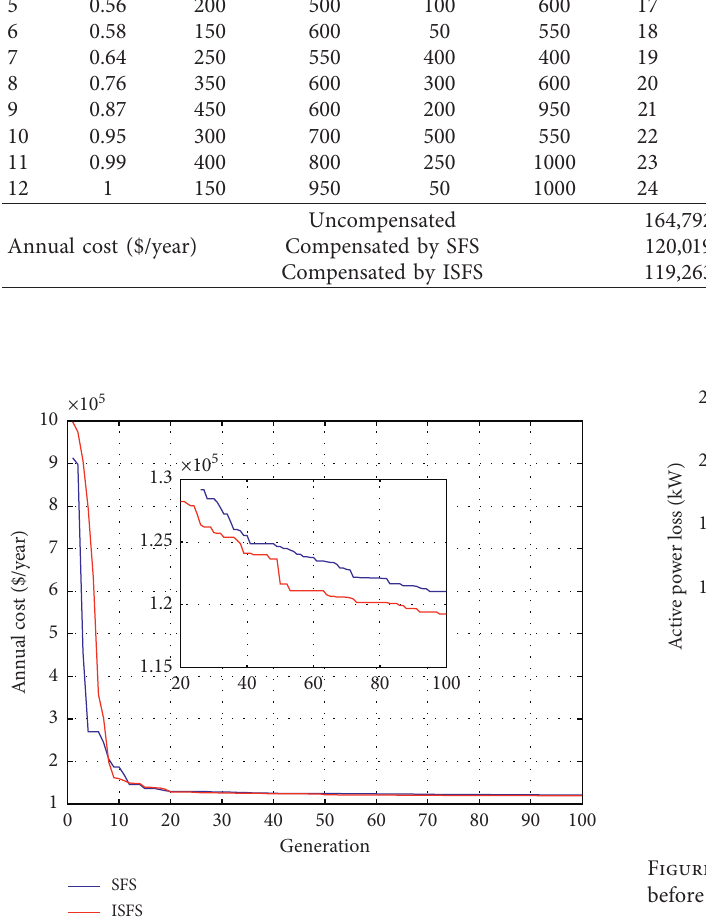
Figure 13: Convergence characteristics of annual cost for 69-bus network in scenario 2.